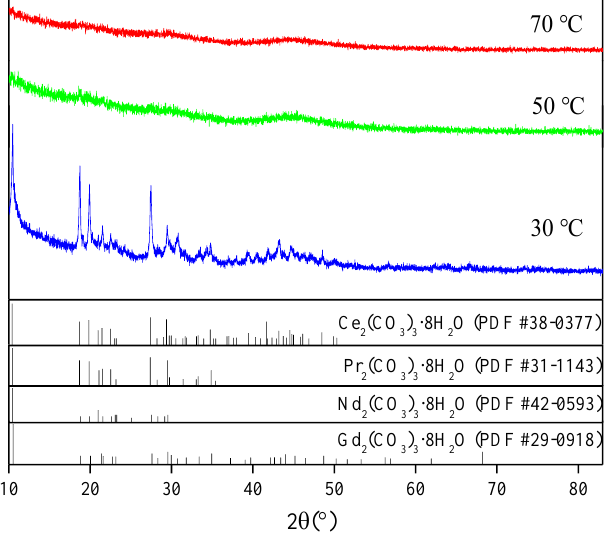
RE 2 (CO 3 ) 3 increased considerably with increased aging time (Figure 9h). In terms of Figure 10. XRD pattern of precipitation products when using different feeding methods.